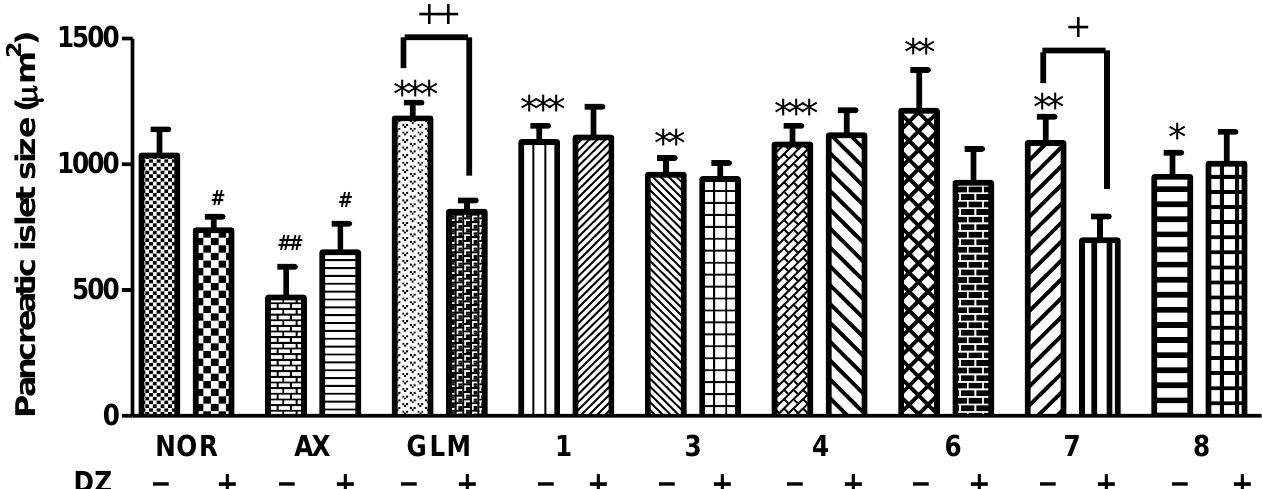
Figure 8. Effect of the isolated compounds for K ATP channel on alloxan-induced diabetic zebrafish: the action of diazoxide (DZ) in the efficacy of compounds 1 , 3 , 4 and 6 – 8 (# p < 0.05, ## p < 0.01; compared to NOR, (* p < 0.05, ** p < 0.01, *** p < 0.001; compared to AX) (+ p < 0.05, ++ p < 0.01).